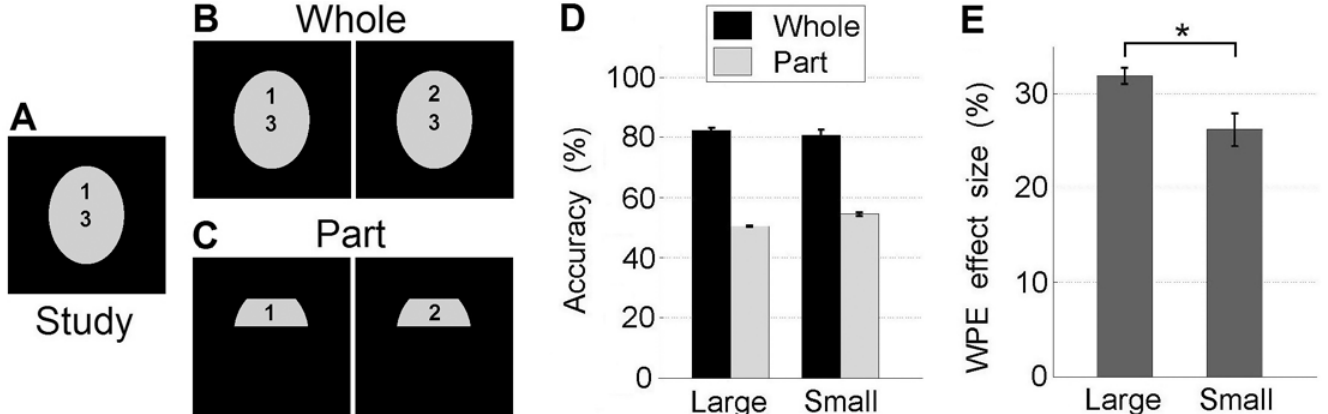
Fig 3. Tuning size accounts for the Whole-Part Effect (WPE). (A) Schematic for Study face. (B) Schematic for Whole condition: two choices (differing only in the eye region) are presented, to be matched to the study face from memory. (C) Schematic for Part condition: two choices (eye regions cropped from Whole condition) to be matched to the study face. (D) Mean accuracies for choosing correctly the Study face. (E) WPE effect size (Whole accuracy – Part accuracy) varies with tuning size. Error bars: